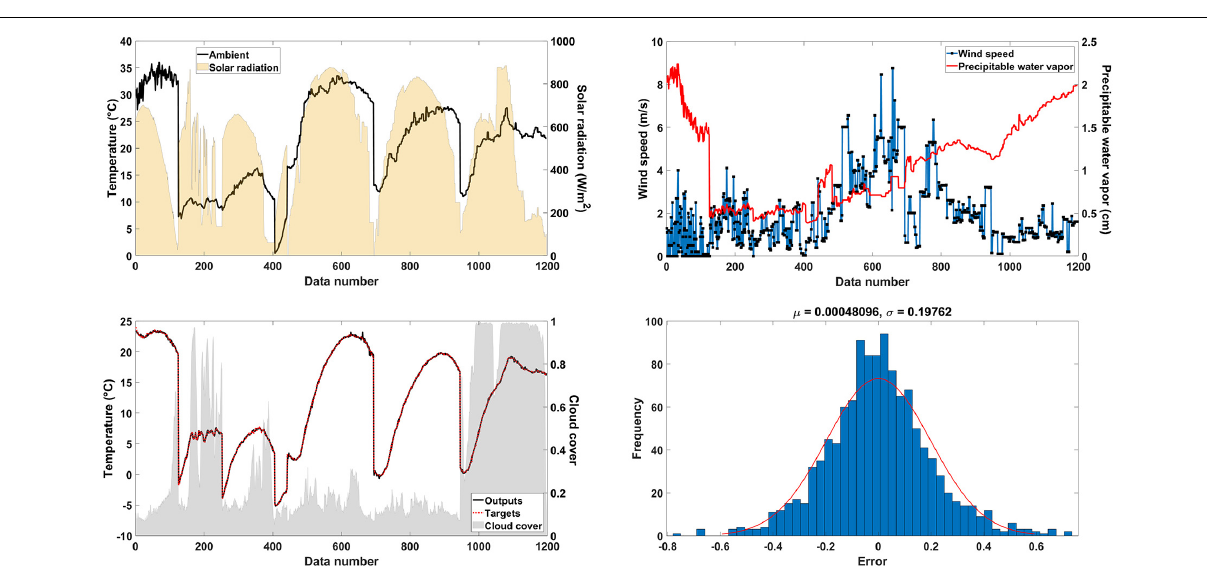
FIGURE 6 | The performance of the ANN model in different climate conditions. (Up-left) the ambient temperature and the solar radiation values versus time (up-right) the wind speed and the precipitable water vapor values of the evaluated points (down-left) output values of ANN and the real target values along with the cloud cover coefficient in the investigated times, and (down-right) the corresponding error